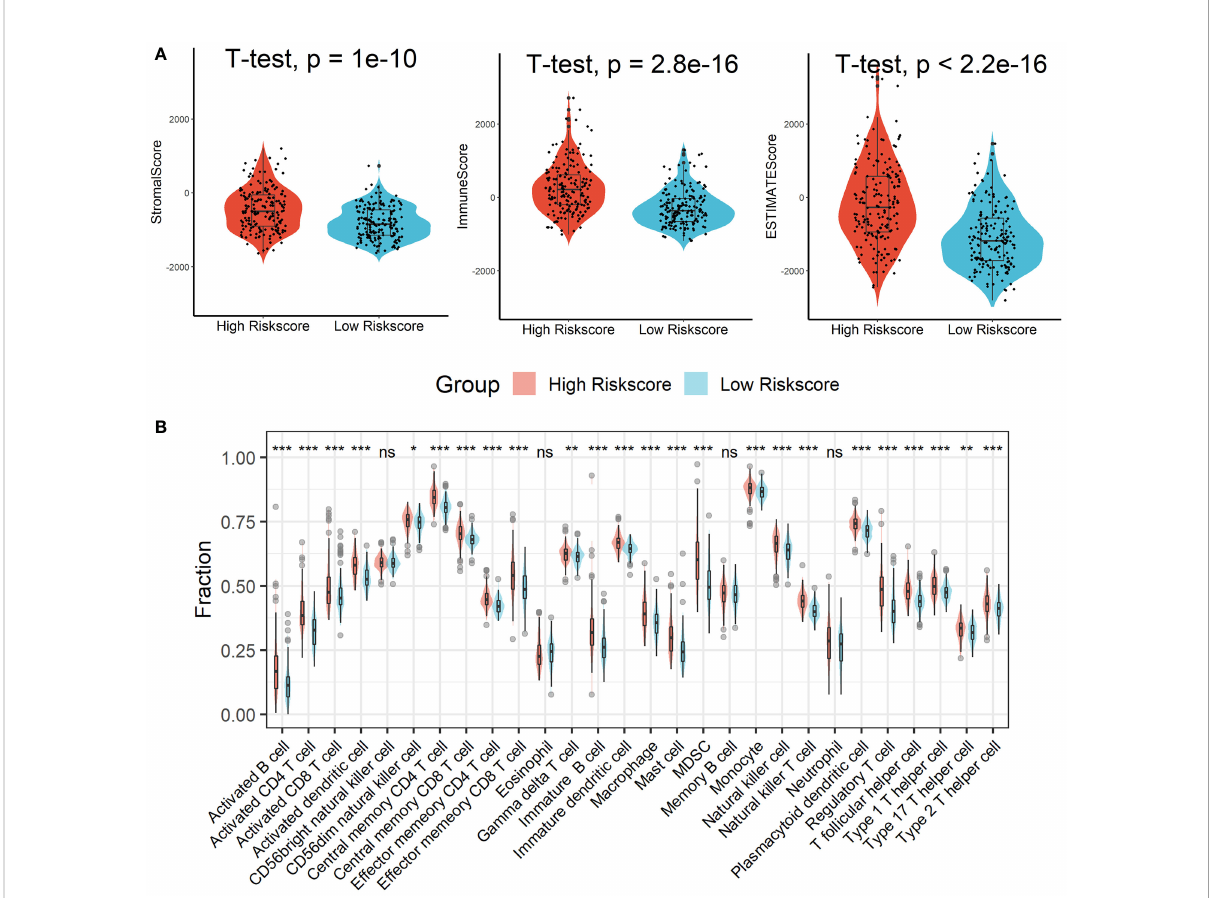
FIGURE 7 Estimation of immune cell in fi ltration in different risk scores groups. (A) Patients in the high-risk scores group had higher immune, stromal, and ESTIMATE scores compared with patients in the low-risk scores group. (B) Almost all types of immune cells were higher in the high-risk scores group than those in the low-risk scores group except for CD56bright natural killer cell, memory B cell, neutrophil, and eosinophil. ns, not signi fi cant; *p < 0.05; **p <0.01; ***p <